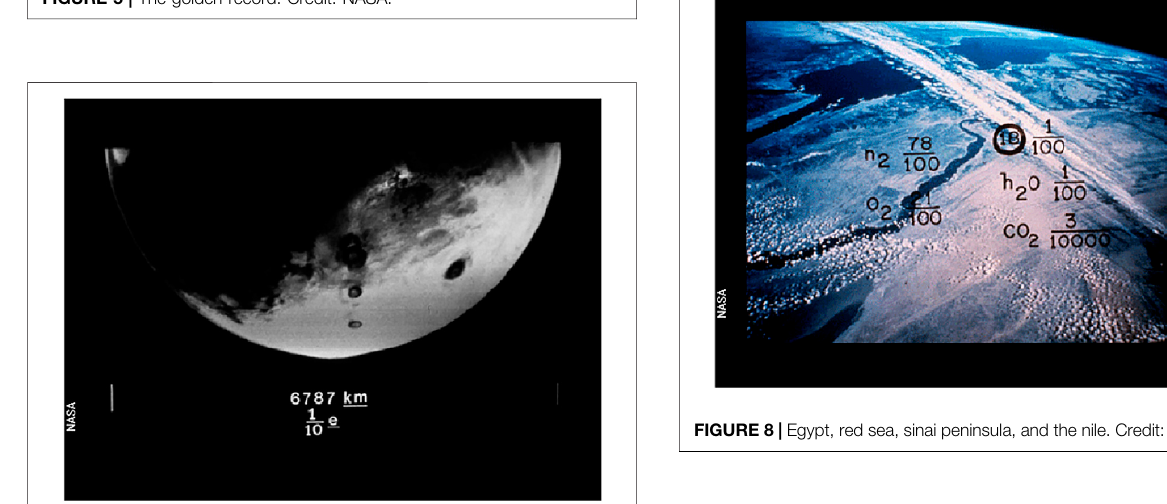
FIGURE 5 | The golden record. Credit: NASA.